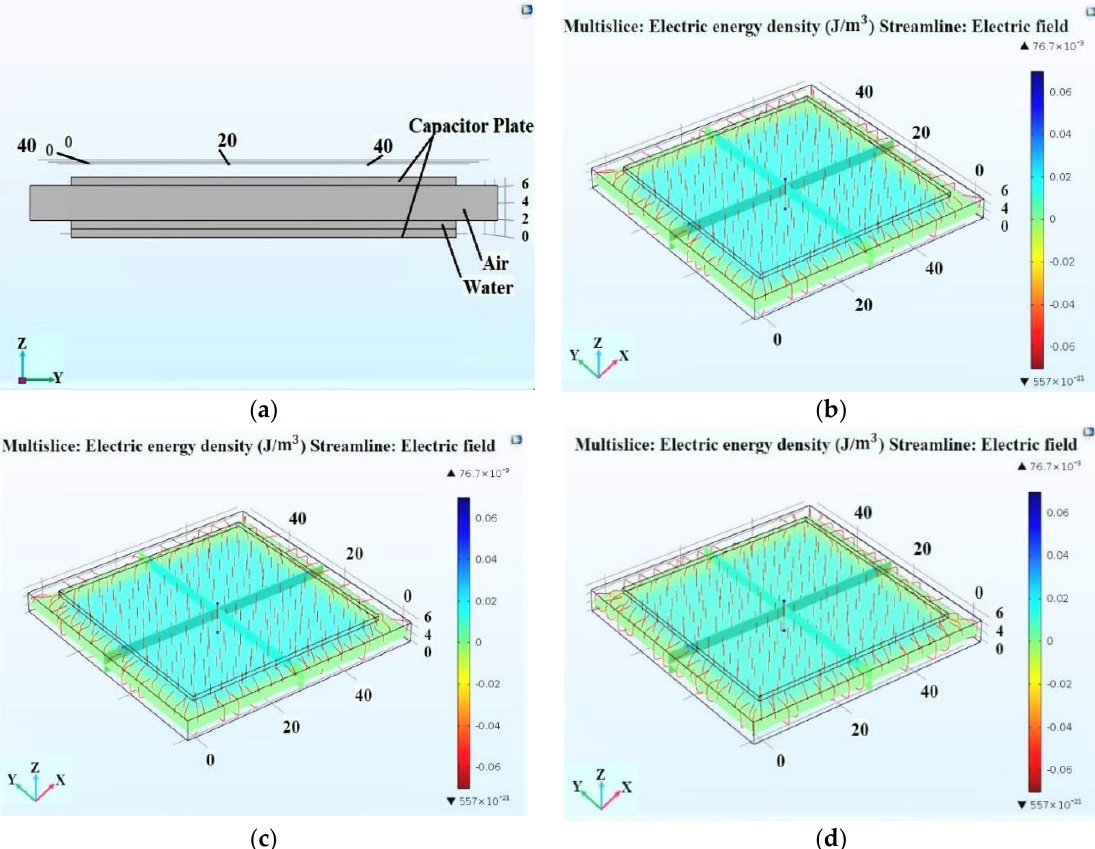
Figure 22. ( a ) Single module Capacitor incorporate with water in ANYSYS Maxwell Simulation. ( b ) Material electric energy density (for water) with coating thickness of 0 mm. ( c ) Material electric energy density (for water) with coating thickness of 0.5 mm. ( d ) Material electric energy density (for water) with coating thickness of 1 mm.